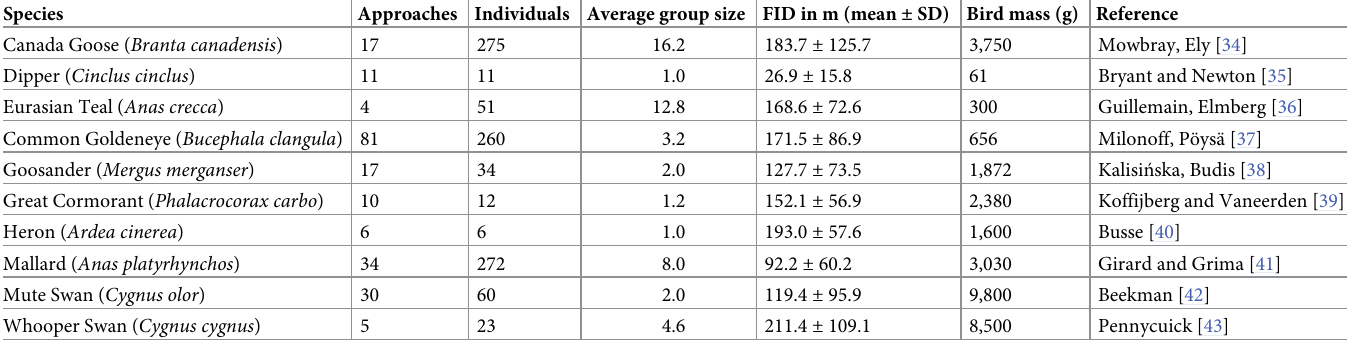
Table 1. Total number of observed individuals, average group size, average FID, and body mass for the nine bird species approached during this study in southeast Norway. Body mass was taken from the literature indicated in the last column.